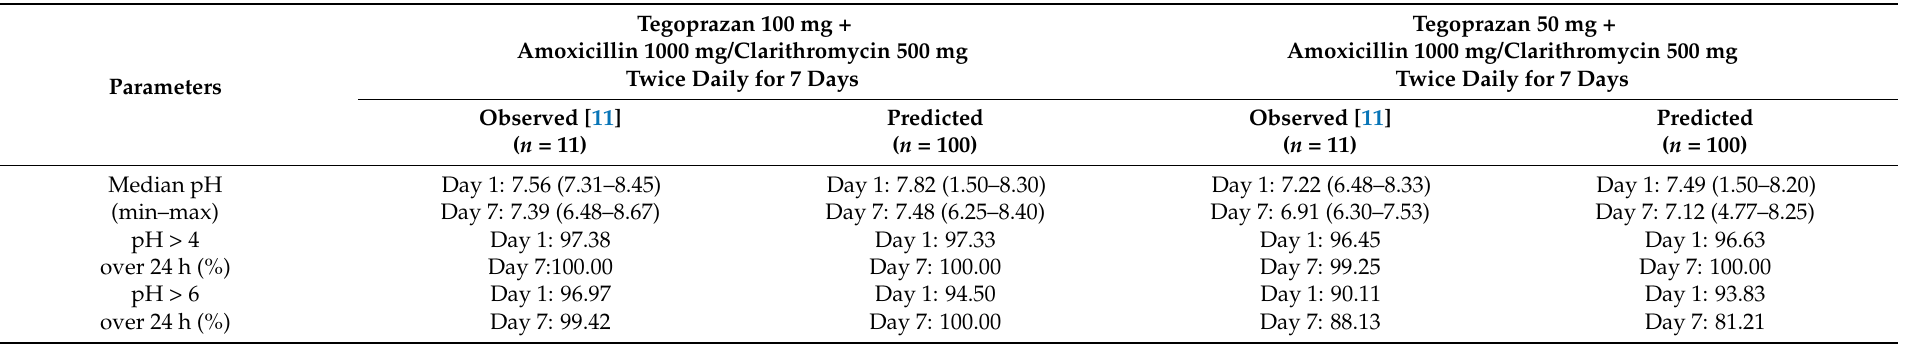
Table 2. The observed and predicted pharmacodynamic endpoints following two different administrations of tegoprazan with amoxicillin and clarithromycin.